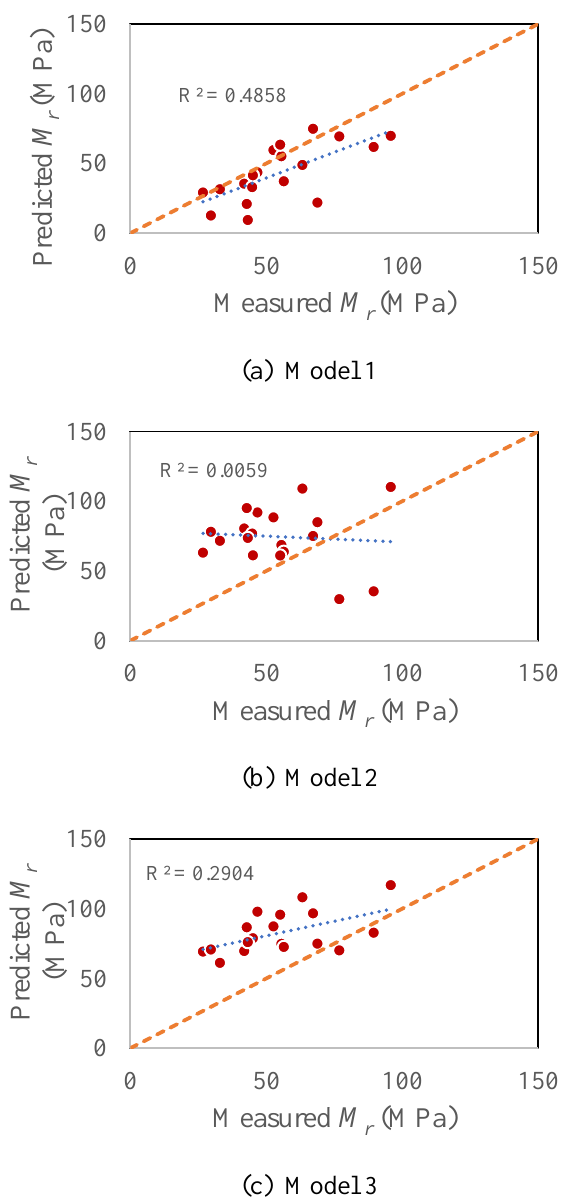
Figure 6. Validation of Developed Model for Undisturbed Soil Samples: ( a ) Model 1 is a correlation between M r and E avg , MC, OMC, DUW, MDUW ( b ) Model 2 is a correlation between M r and q u , S 1% , ( c ) Model 3 is a correlation between M r and E avg.